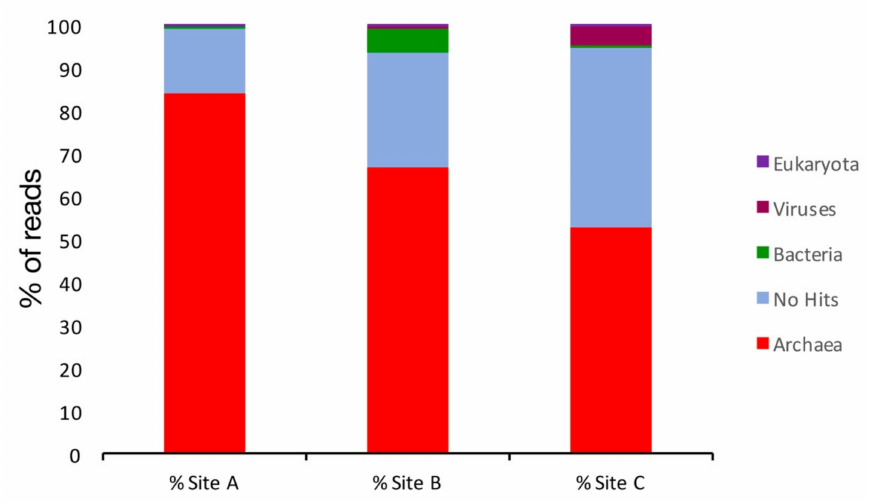
Figure 2. Taxonomic assignment of the reads at the kingdom